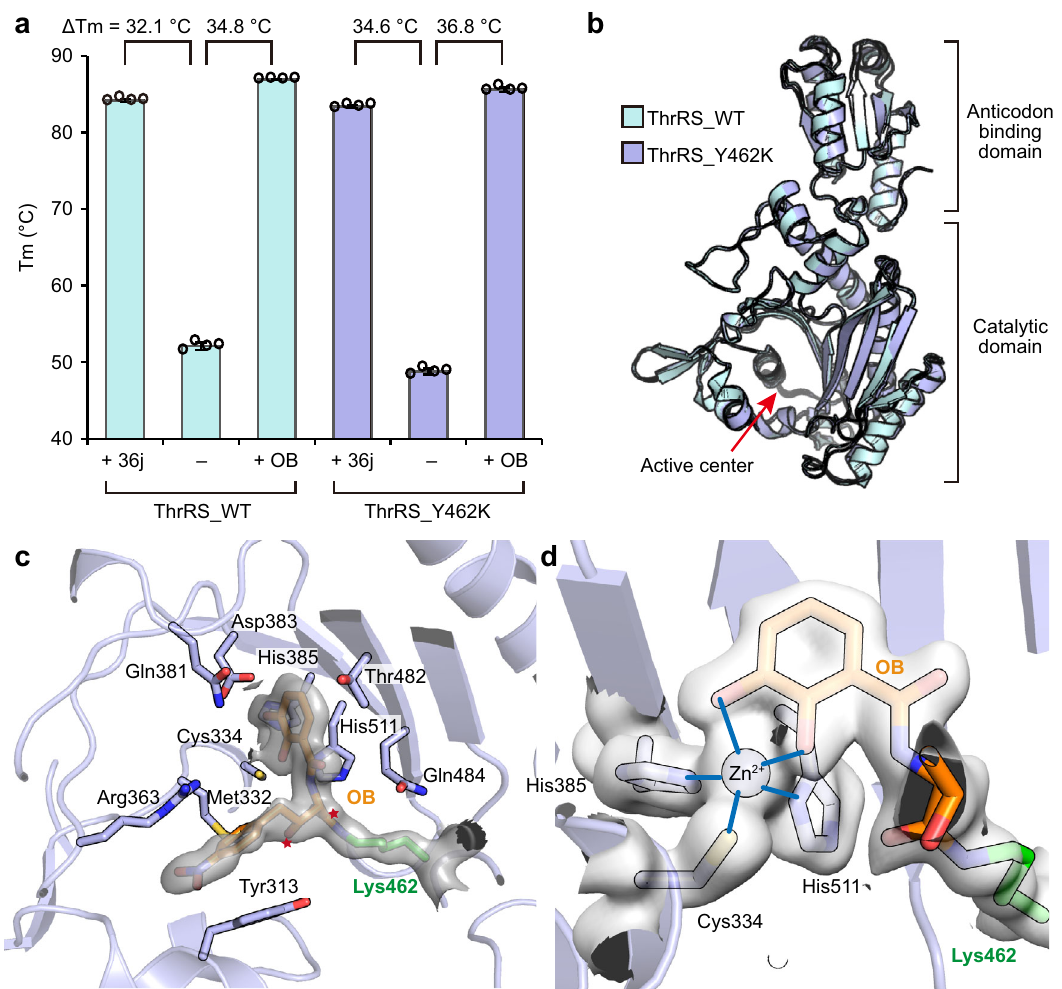
Fig. 4 OB covalently modi fi es the engineered Lys462. a Diagram of the Tm value of ThrRS_WT and ThrRS_Y462K in the presence or absence of OB and 36j. Evaluations were carried out in four repeats, and error bars indicate the respective standard deviation ( n = 4, mean value ± SD). All data points are shown in small circles. Numerical Data can be found in Supplementary Data 1. b Superimposition of the structures of ThrRS_WT-OB and ThrRS_Y462K-OB. The r.m.s.d is 0.421 Å over 322 C α atoms. c The catalytic center of ThrRS_Y462K bound to OB. The ε -amino group of Lys462 (presented as green sticks) forms an amide bond with OB (presented as orange sticks). The linkage atoms of the original 4-membered ring in OB are indicated by red stars. Interacting residues are shown as sticks. The 2Fo-Fc electron density of Lys462-OB (contoured at 1.0 σ ) is shown as a transparent surface. d Close-up view of residues coordinating with a Zn 2 + ion. The 2Fo-Fc electron density of the involved residues (contoured at 1.0 σ ) is shown as a transparent